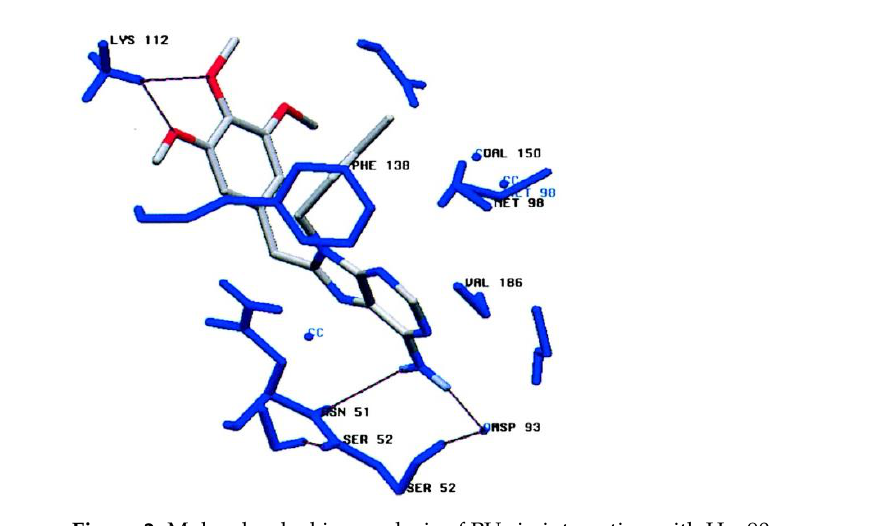
Figure 2. Molecular docking analysis of PU 3 in interaction with Hsp90.